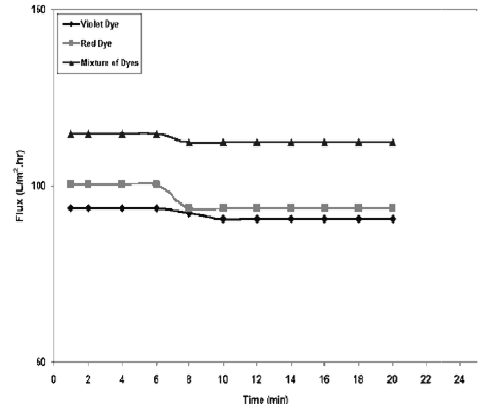
ig.17. The com ncentration = with that of ind